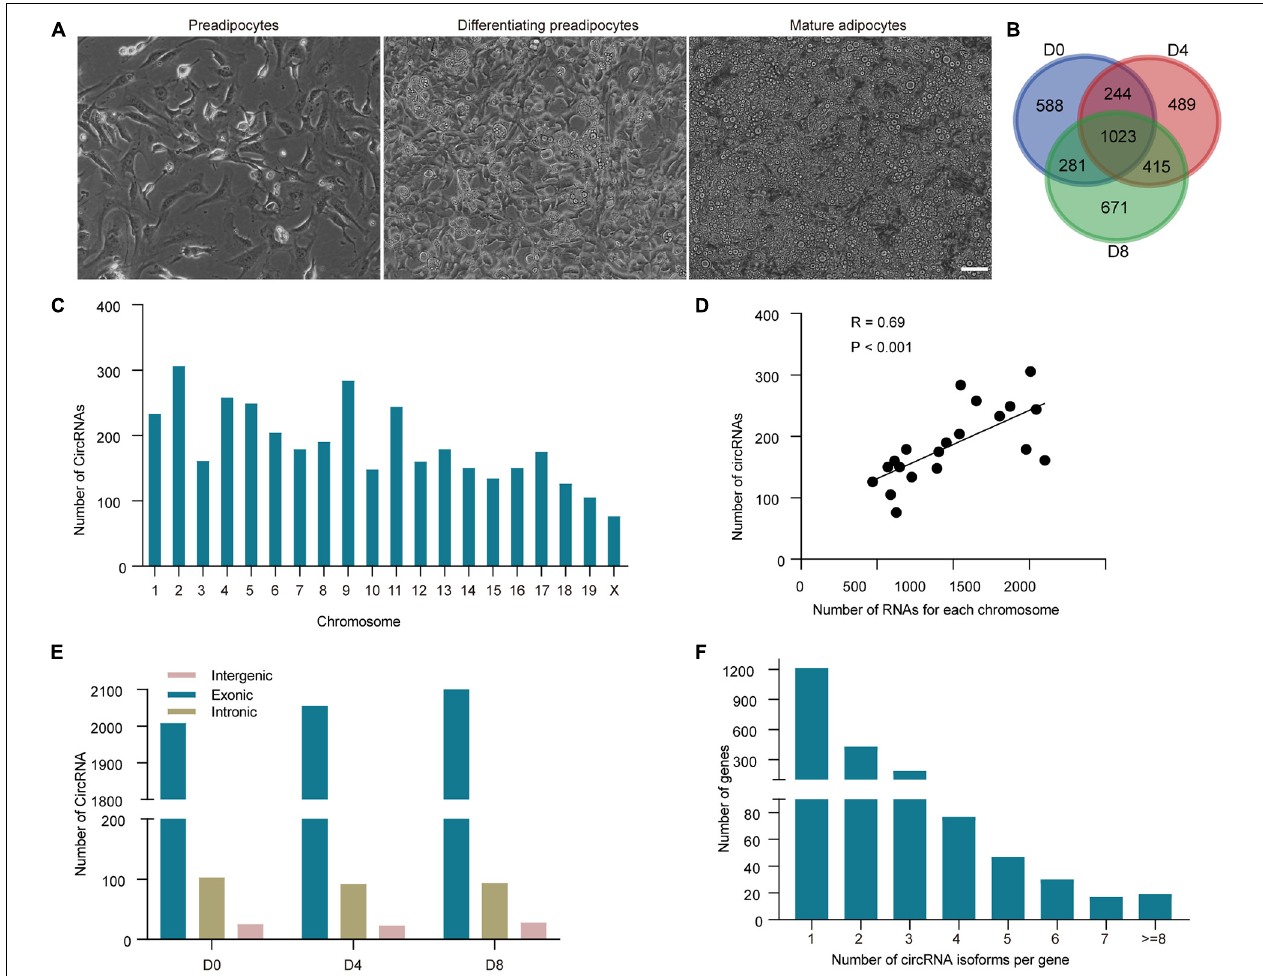
FIGURE 1 | Identification and characterization of circRNAs in white adipogenesis. (A) Representative pictures of WAT adipocytes during adipogenesis. Scale bar, 20 µ m. (B) Identification of circRNAs at each adipogenesis stage. (C) Distribution of circRNAs on each chromosome. (D) Association of circRNAs and mRNA numbers from the same chromosome. (E) Genomic origins of the circRNA type in each adipogenesis stage. (F) The number of circRNAs derived from per